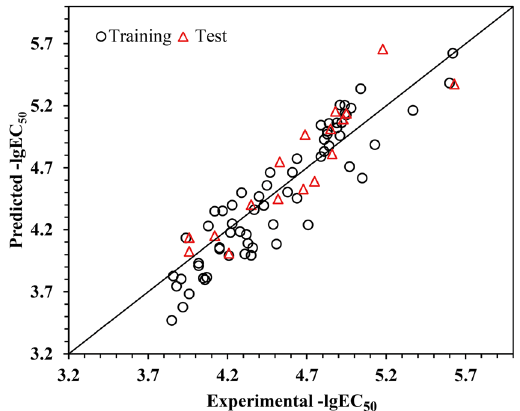
Figure 7. Plots of experimental versus predicted − lgEC 50m,c by model